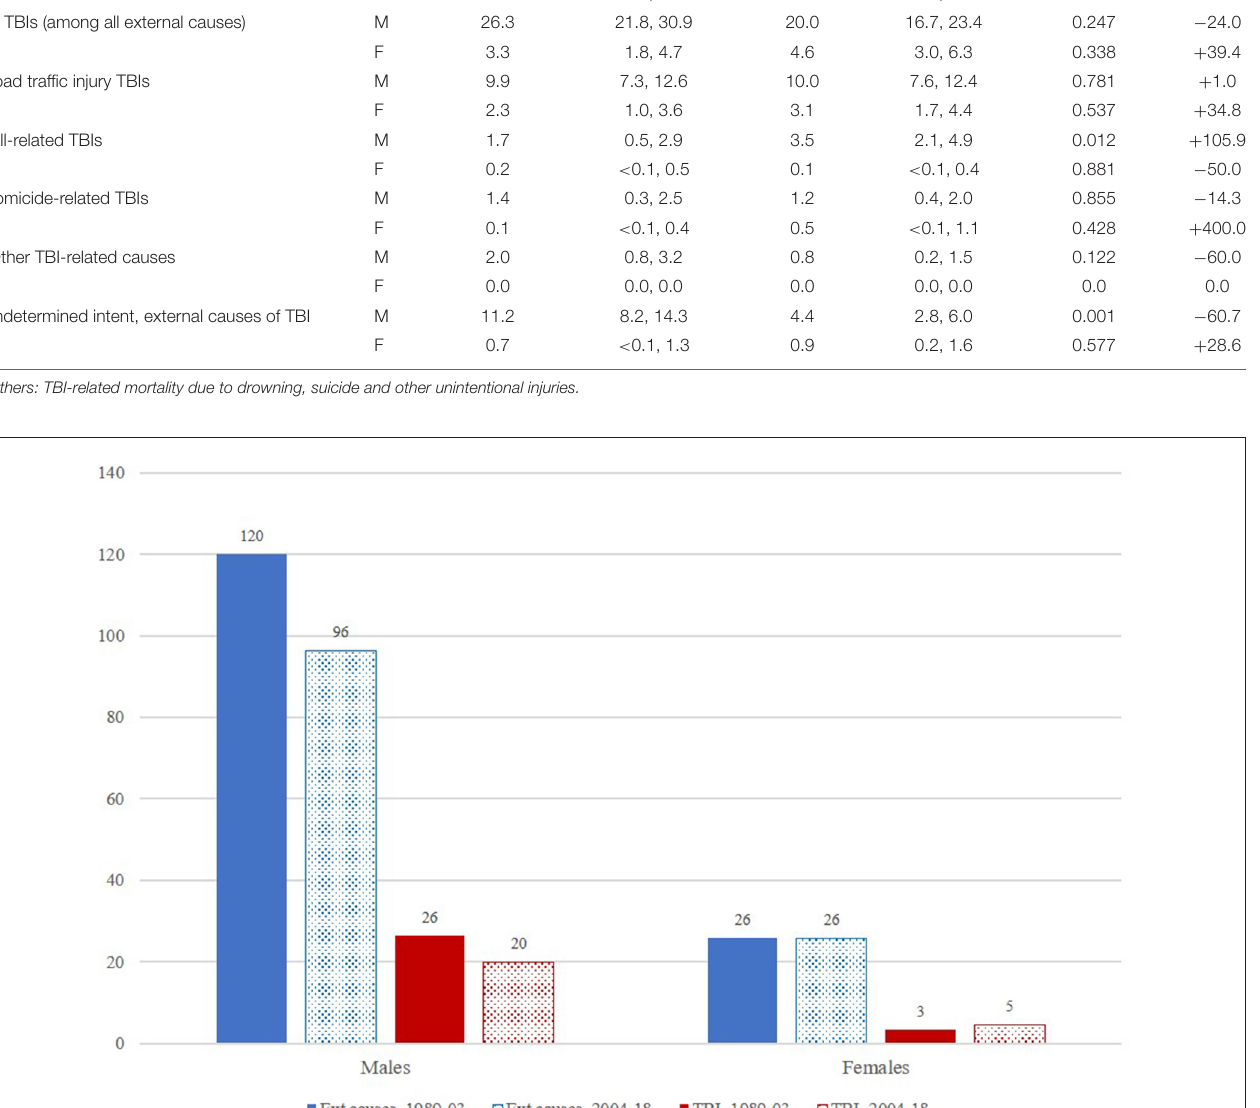
males (males 4.4; females 0.9). Road traffic injuries corresponded to 50% (10.0/20.0) of the overall TBI mortality in males and 67% (3.1/4.6) in females. Considering the period 1989–2018 (30-years), the age-standardised TBI mortality from road traffic